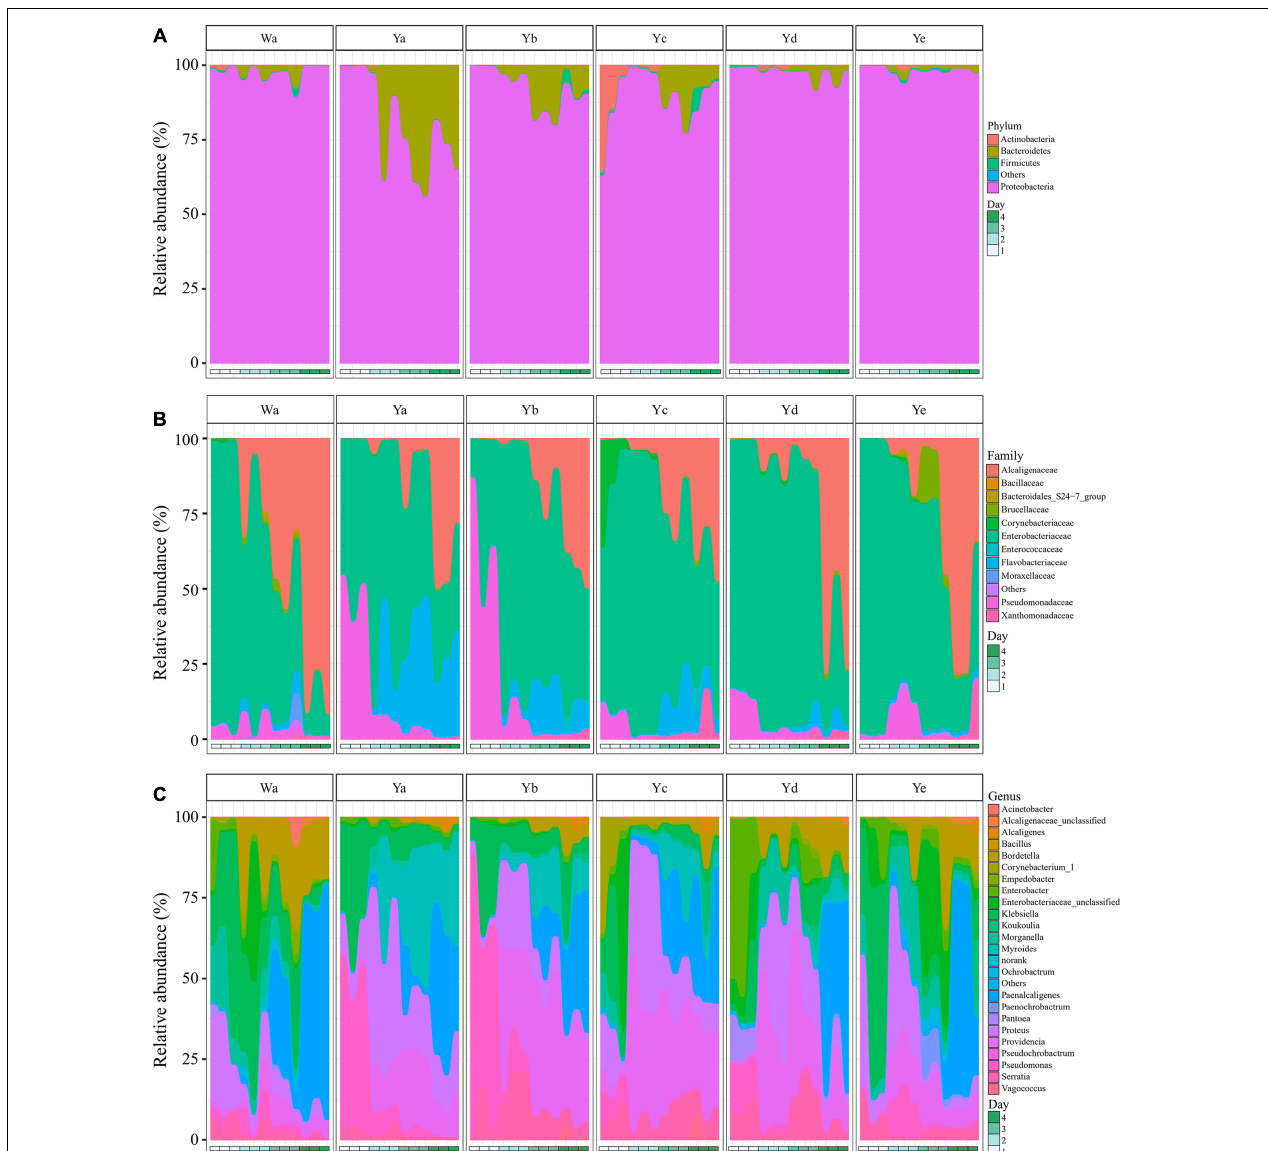
FIGURE 3 | Relative abundances of bacterial components in samples of housefly larvae fed with different dilution concentrations of P. aeruginosa . (A–C) represent the relative abundances of bacteria at the phylum, family and genus classification levels, respectively. Wa, Ya, Yb, Yc, Yd, and Ye represent housefly larvae samples fed diets with sterile water, P. aeruginosa stock solution, and the stock solution diluted 10 2 , 10 4 , 10 6 , and 10 8 fold,